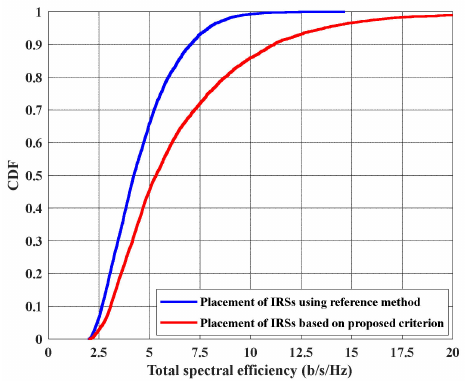
Figure 5. CDF of total spectral efficiency when placing the two IRSs using the proposed method, where IRSs positions are in (10, 0) and (10, 20), and using ref. [27] method, where IRSs positions will be in (0, 20) and (20, 20).